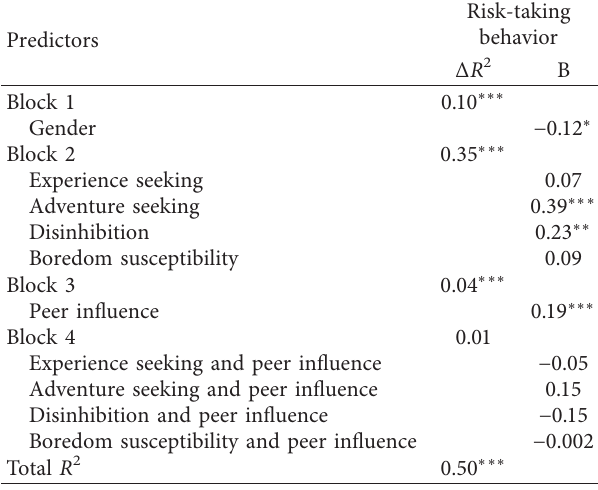
Table 4: Multiple hierarchical regression (moderation) analysis predicting risk-taking behavior from subscales of sensation seeking and peer influences ( N �